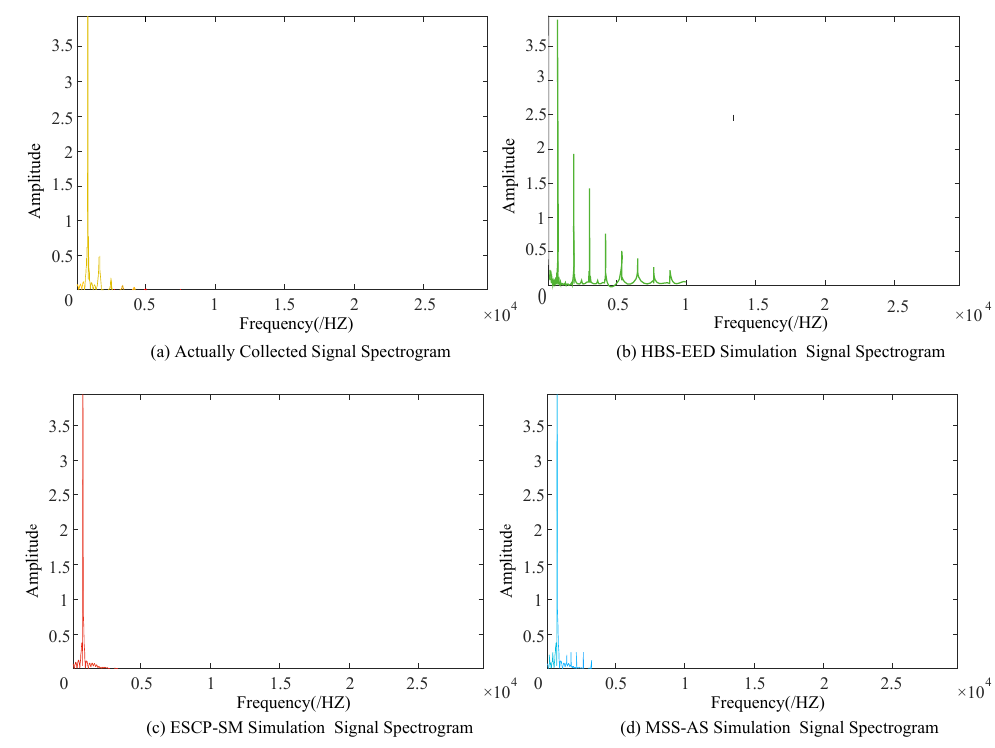
Figure 22. Spectrum analysis